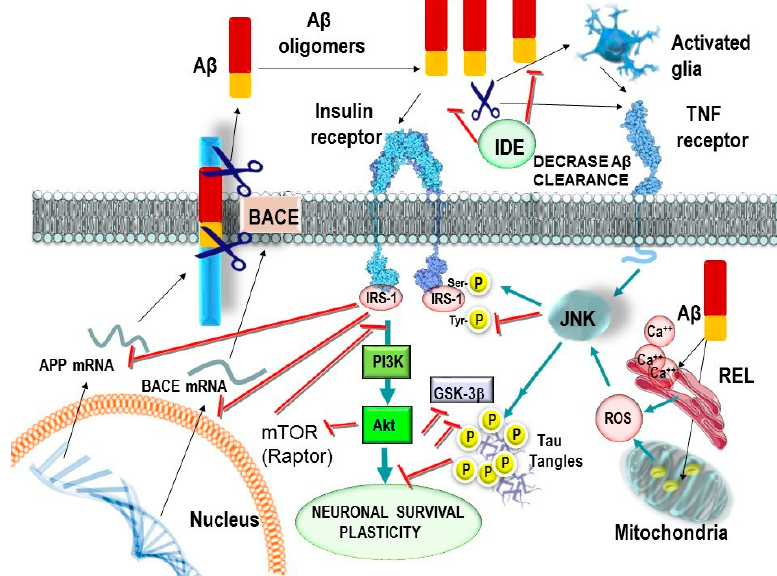
Figure 1. Consequences of insulin and A β interactions on reduced neuronal IR signalling. In type 2 diabetes, there can be decreased or increased levels of insulin in brain, along with IR desensitization. Soluble A β oligomers block IR. Increased A β levels will compete for insulin degrading enzyme (IDE) against cerebral insulin. Reduced IR signalling results in downstream negative effects on PI3K activity and proteins like PKB/AKT. Consequences of this include: reduced glucose metabolism and increased oxidative stress which modulate APP and JNK activity. Moreover, reduced GSK3 β phosphorylation leads to up-regulation in TAU phosphorylation and A β formation. Likewise, A β promotes the activation of microglia increasing the levels of cytokines, mainly TNF α that activates JNK that subsequently inhibits the brain IR. On the other hand, A β can alter the endoplasmic reticulum and the mitochondria, generating free oxygen radicals that modulate APP and JNK.